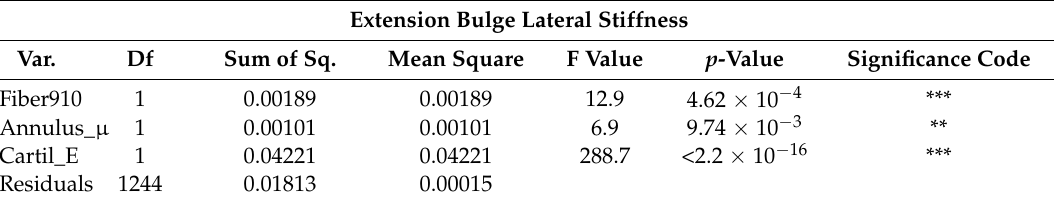
Table 16. ANOVA table for an extension bulge lateral linear model. Extension Bulge Lateral Stiffness